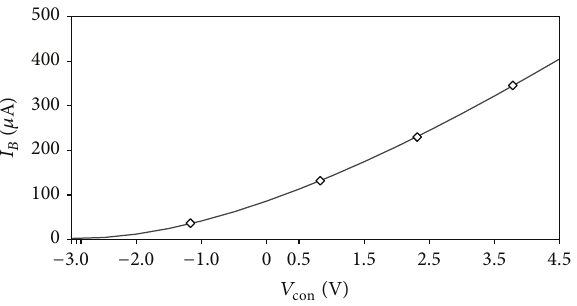
Figure 10: Simulated result of proposed comb filter. . con